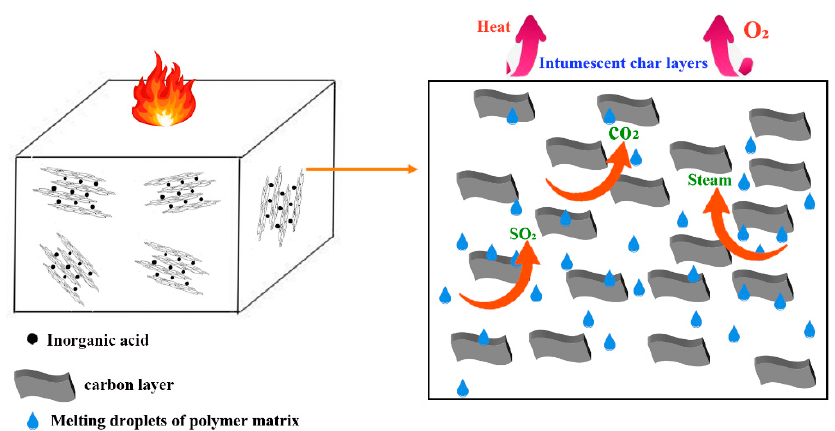
Figure 5. Schematic diagram of the flame retarding mechanism of EG .